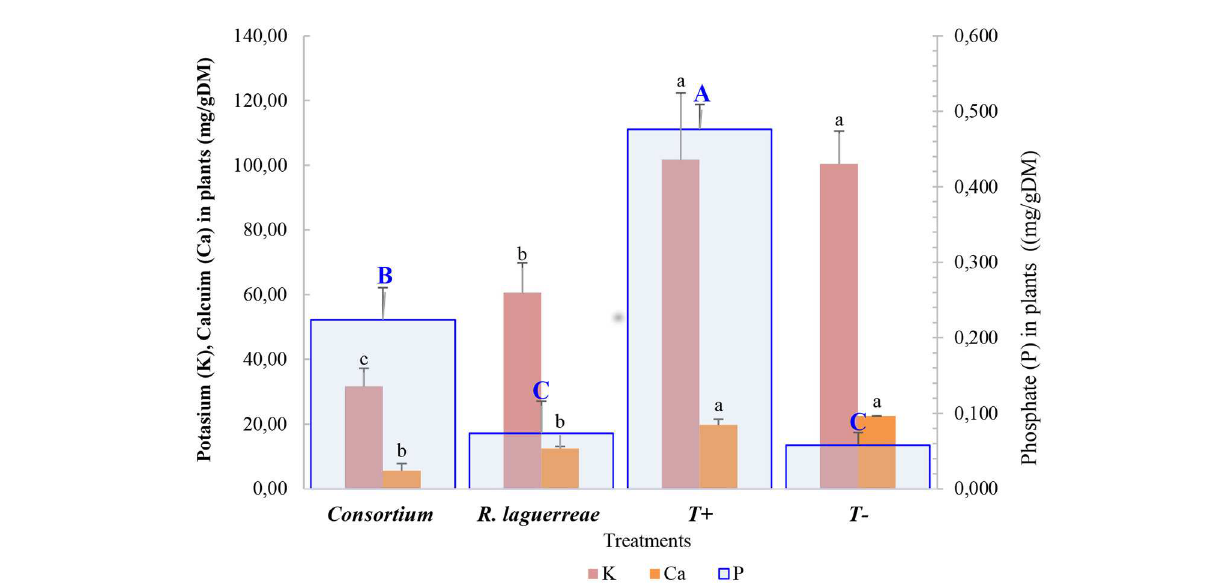
FIGURE9 Minerals (K and Ca) and P content in the faba-bean plant in response to different treatments. For each element, different letters indicate that values are statistically different at a P -value of ≤ 0.05.